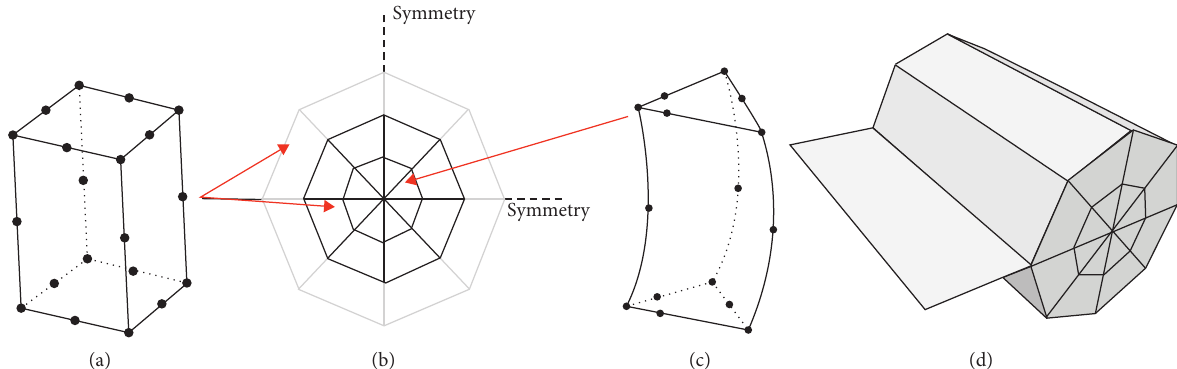
Figure 3: Element distribution and crack tip types. (a) Hexahedral element. (b) Element rings. (c) Singular wedge-shaped element. (d) Integral domain.